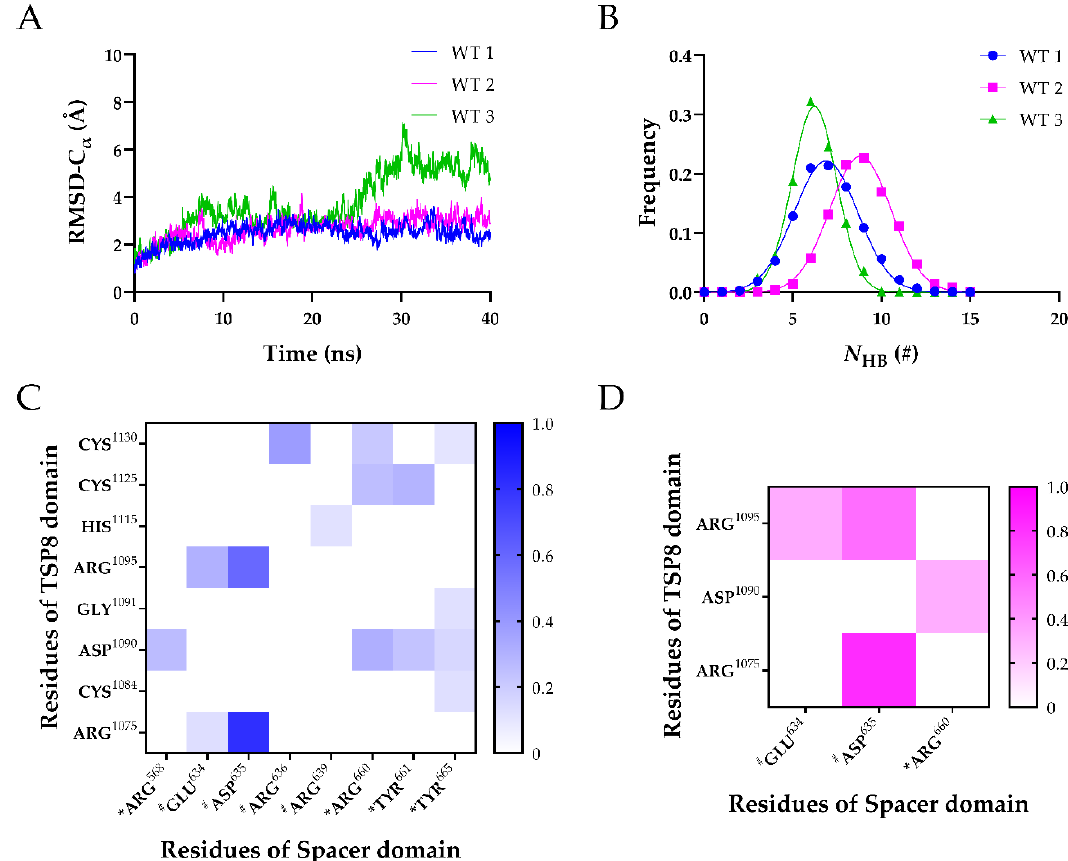
Figure 3. Three FMD simulations of the WT TSP8-Spacer complex. ( A ) Variation of Cα -RMSD of WT1 (blue), WT2 (magenta), and WT3 (green) with time. The Cα -RMSD value fluctuated mildly when the time exceeded 30 ns; ( B ) Gaussian fitting of the N HB frequencies of three complexes (R 2 > 0.99). The heat maps of average survival ratios of H-bonds ( C ) and salt bridges ( D ) on the interface of the TSP8-Spacer complex. * Indicates residues in exosite-3 of the Spacer domain, and # indicates residues in exosite-4 of the Spacer